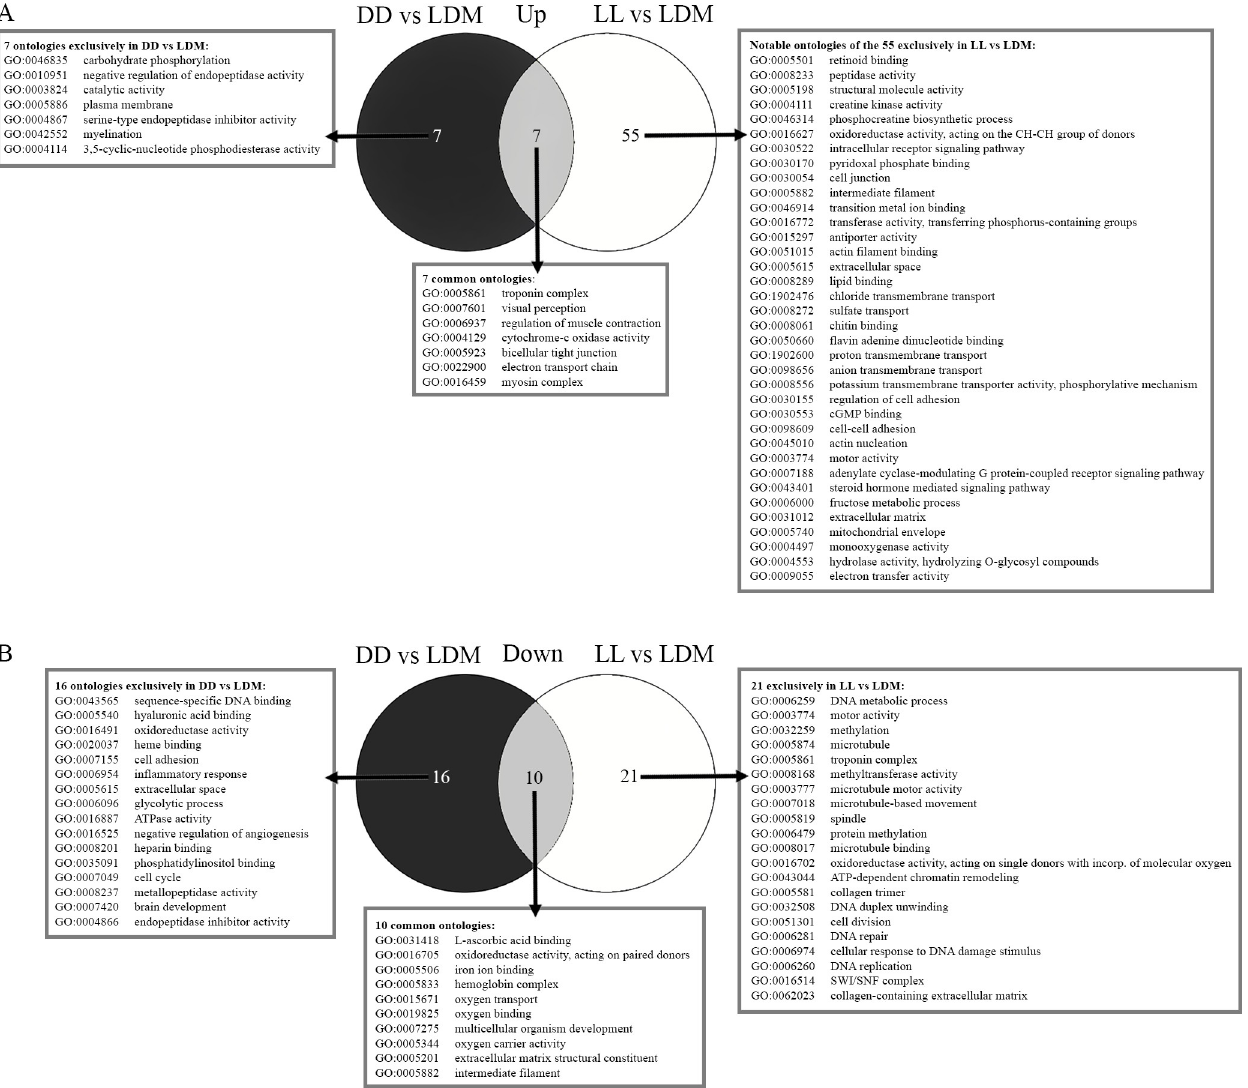
Fig 5. Venn diagrams of Gene Ontologies (GO) comparing different photoperiods. A) Upregulated GO terms comparing a constant lighting environment (DD or LL) to LDM revealed 7 common ontologies. In LL, 55 GO terms were upregulated (see S8 Table for a complete list). B) Downregulated GO terms comparing constant environment (DD or LL) to LDM, 10 common ontologies were